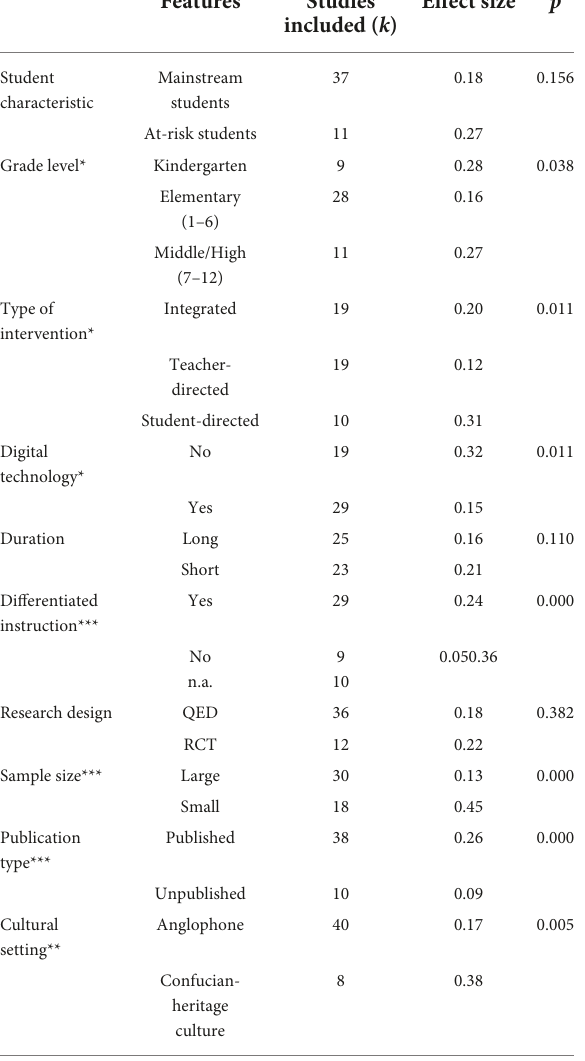
TABLE 4 Subgroup analysis